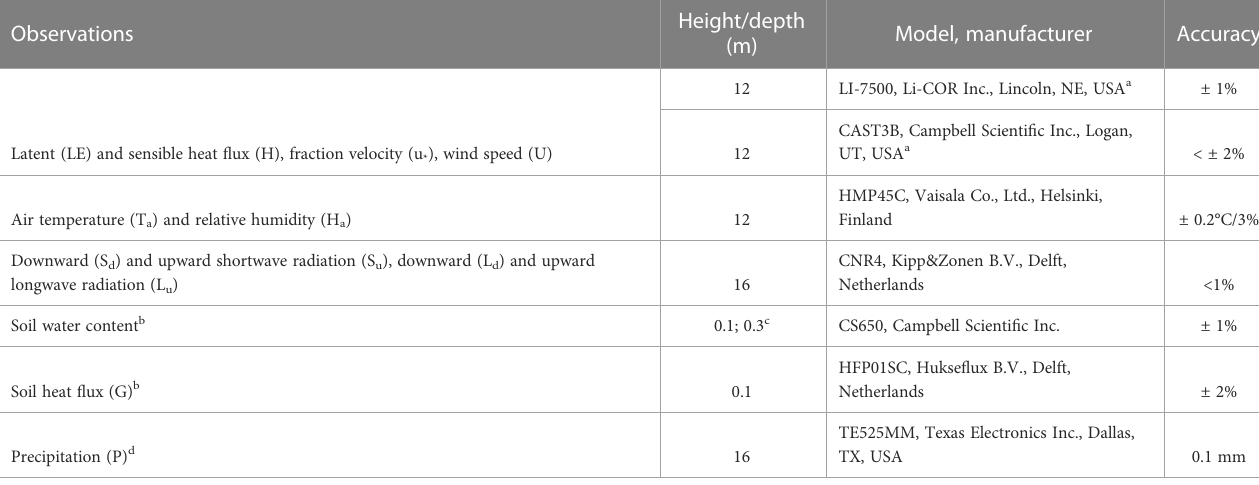
TABLE 1 List of measured items and environment monitoring instruments installed on the tower in the Pinus tabuliformis plantation.